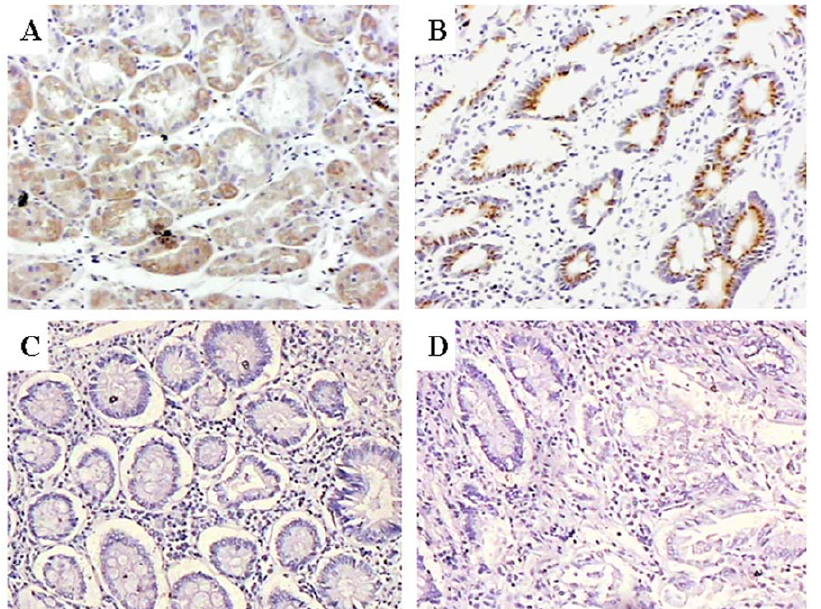
Figure 5. Representative immunohistochemical staining in serial sections of poorly differentiated adenocarcinoma of the stomach from patients positive for AFP (magnification 6 100). (A) Immunostaining for AFP. (B) Strong STAT3 immunostaining with brown granular deposits in the cytoplasm and nuclei. (C) Negative control immunohistochemical staining for AFP. (D) Negative control immunohistochemical staining for